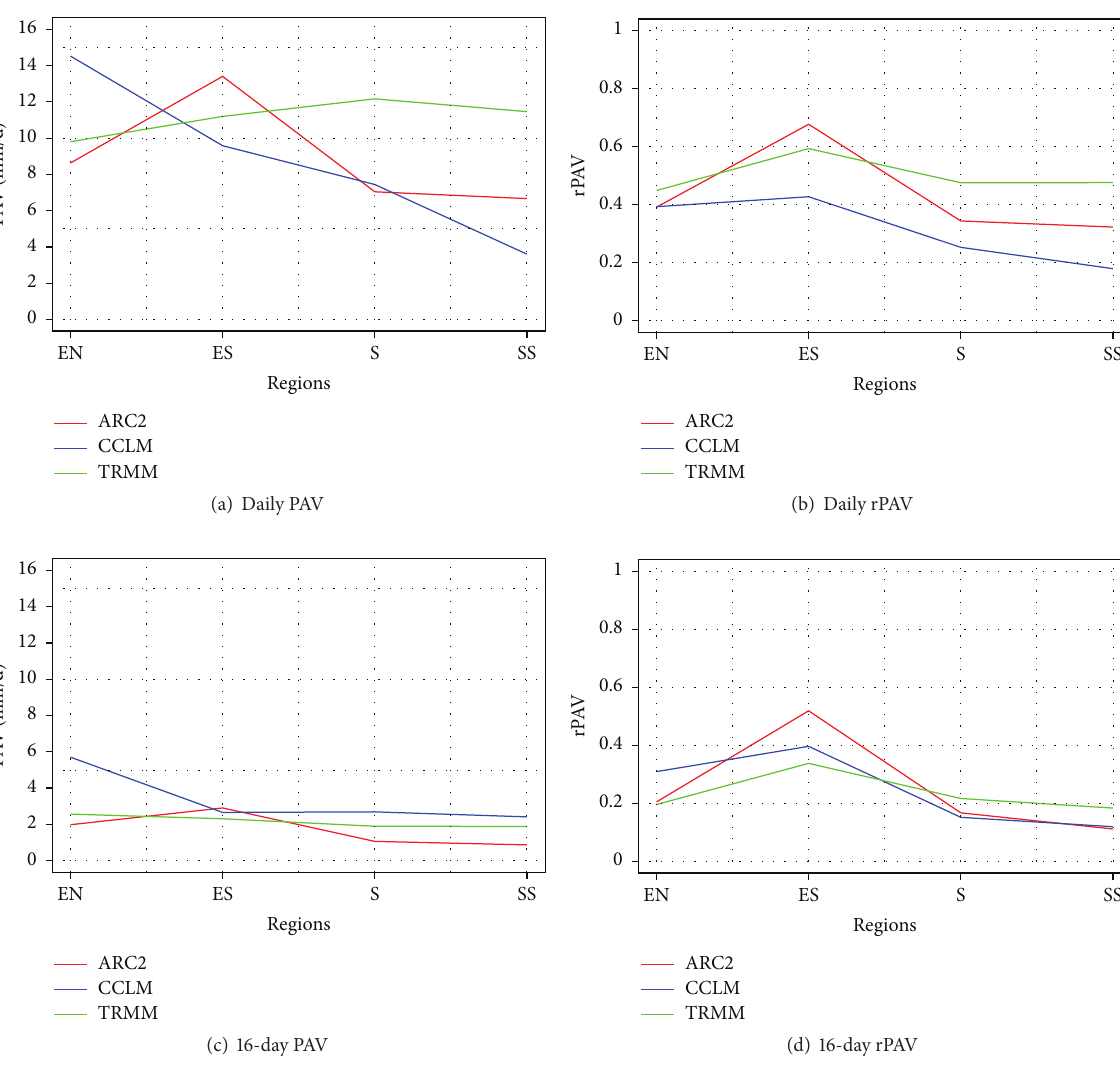
Figure 7: Potential (left) and relative potential (right) added value of daily (top) and 16-day aggregated (bottom) precipitation from ARC2, TRMM, and COSMO-CLM over the 4 East African regions; (a) daily PAV, (b) daily rPAV, (c) 16-day PAV, and (d) 16-day